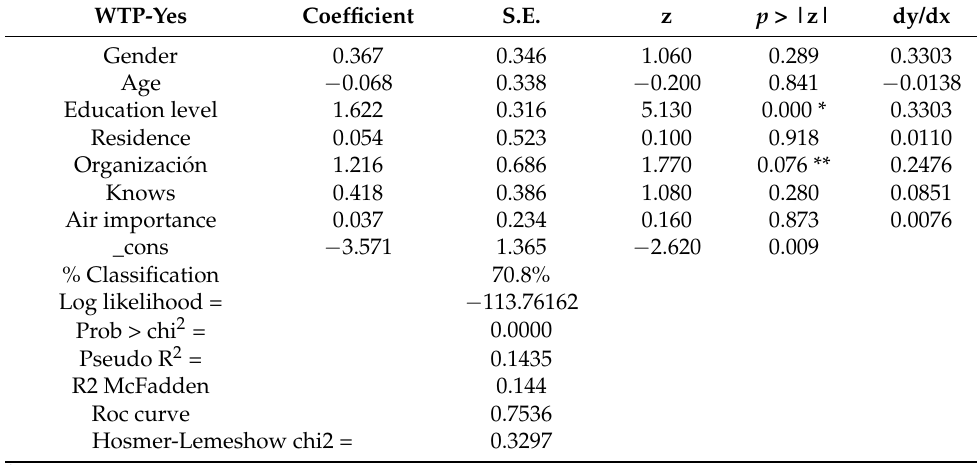
Table 3. Logit model with marginal effects.